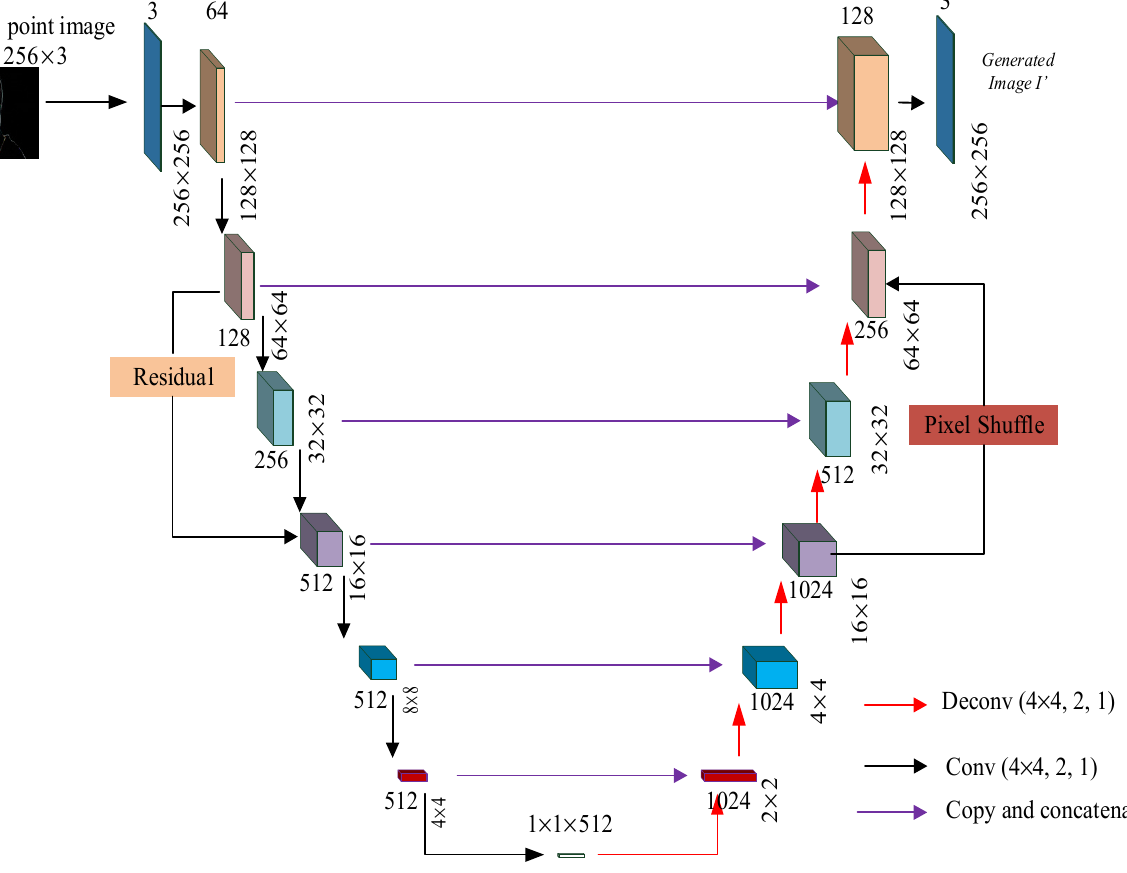
Figure 3. Proposed generator network.